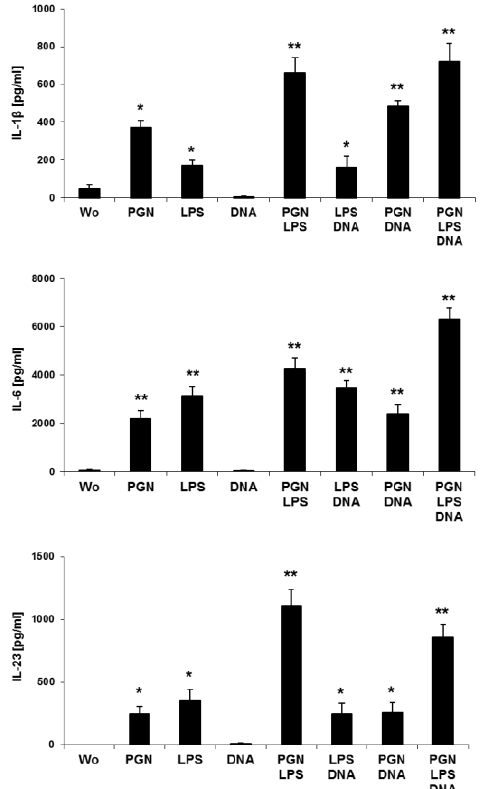
Figure 3. Triple TLR agonist activation increases crucial LC cytokines. MoLCs were activated by combinatory TLR2, TLR4 and TLR9 agonists: 20 µ g/mL PGN, 1 µ g/mL LPS, and 5 µ g/mL DNA, respectively. The amounts of IL-1 β , IL-6, and IL-23 were detected in supernatant after 48 h. ELISA bars show mean of cytokine values from four donors. Differences of values for cytokines after stimulation were analyzed for statistical significance and compared to control (without, wo); * p ≤ 0.05, ** p ≤ 0.01.